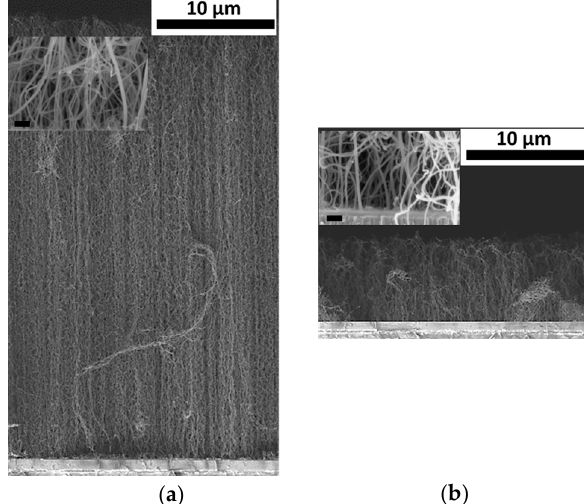
Figure 3. SEM image of CNT forests grown under different conditions giving rise to different heights and tubes densities ( a ) with 4 nm-thick Fe catalyst for 10 min; ( b ) with 10 nm-thick Fe catalyst for 3 min. The insets show the difference in tubes separation. Scale bars in both cases are 200